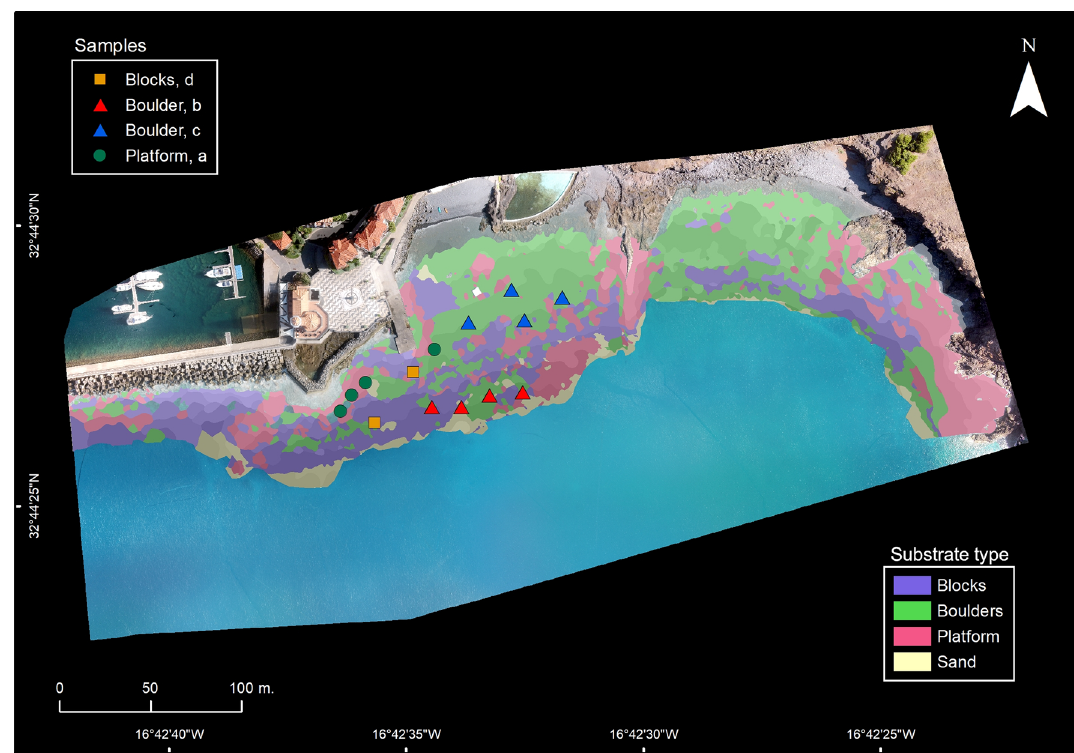
Figure 3. Substrate map derived from ortho-photomosaic analysis (coloured layers indicate substrate type; bottom-right label box) with location of underwater photoquadrat surveys, (shape indicates dominant substrate; colour indicates organism assemblage; top-left box). Map and figure generated in ESRI ArcGIS Desktop